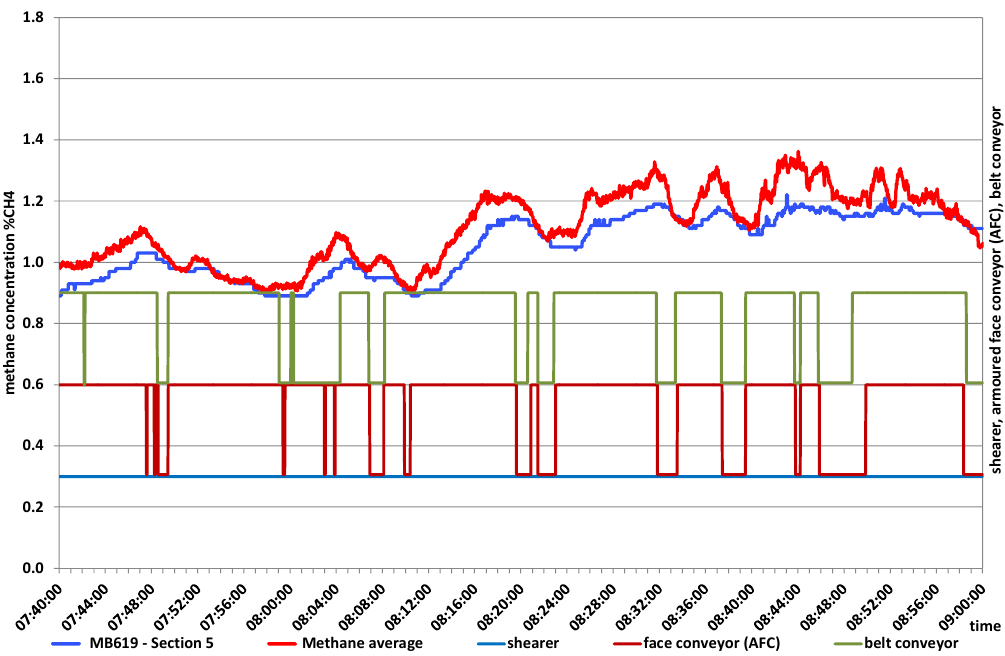
Figure 10. Comparison of the recorded methane concentration for the wireless sensor MB619 (section 5) and the average methane concentration in the cross-section of longwall Cw-4, recorded by the multi-point system (section 7).